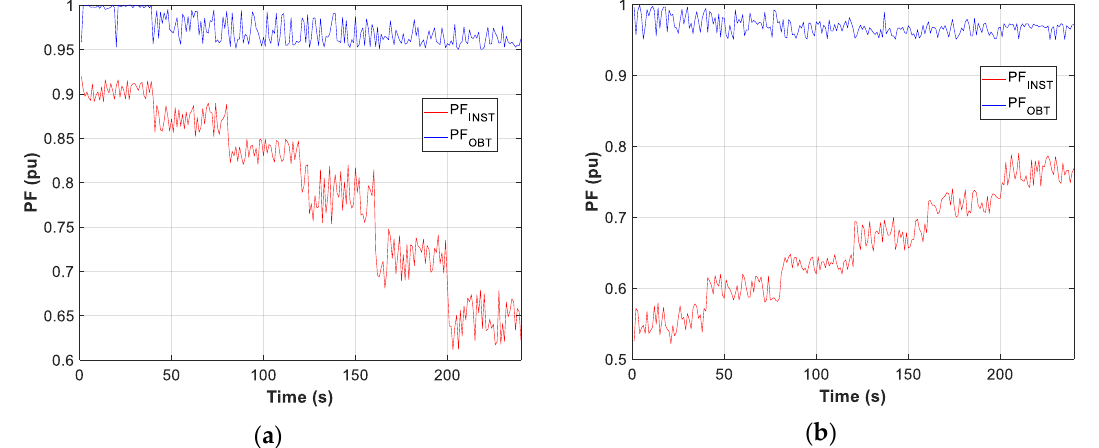
Figure 18. Comparison PF INST vs PF OBT : ( a ) Series connection; ( b ) Parallel connection.